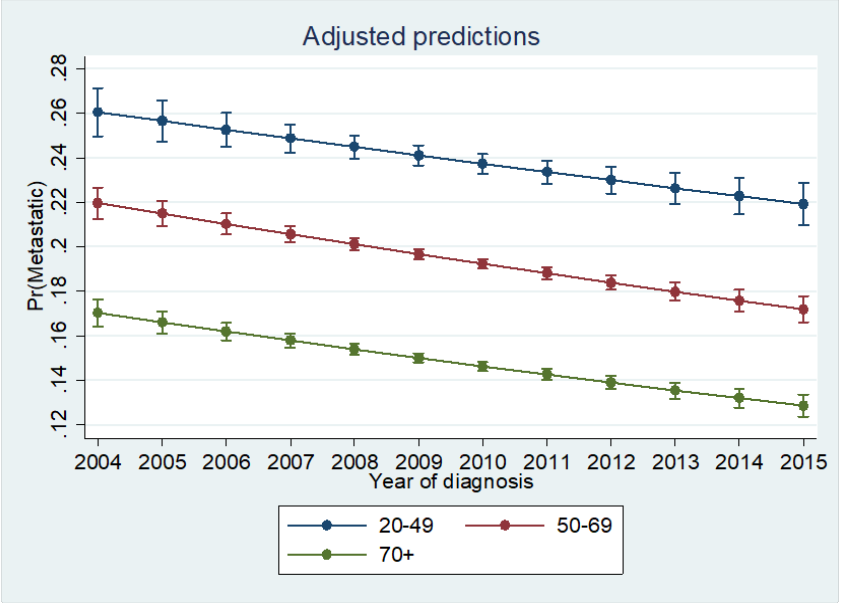
Figure 6. Predicted probabilities across age groups presenting with Stage IV disease for the follow-up period. 20–49 = age from 20 to 49, 50–69 = age from 50 to 69, 70+ = age 70 years and older; Pr (Metastatic) = probability of presenting with metastatic CRC.